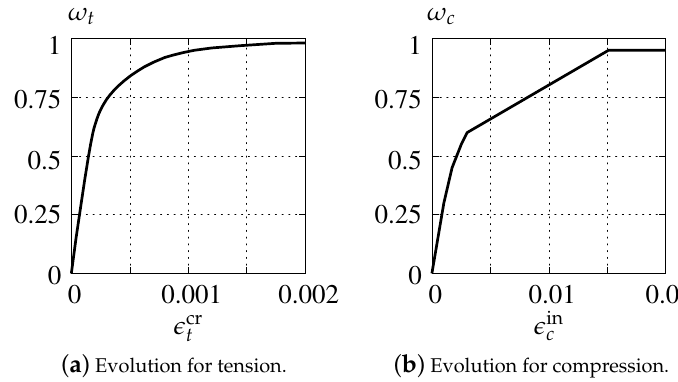
( b ) Evolution for compression. Figure 8. Damage growth functions for CDP model.